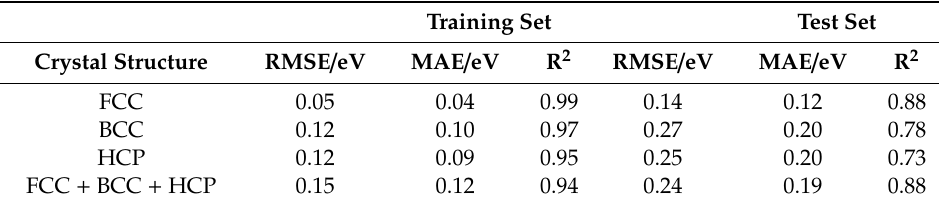
Table 4. RMSE, MAE and R 2 values for training and test sets obtained from the GBR model using 5